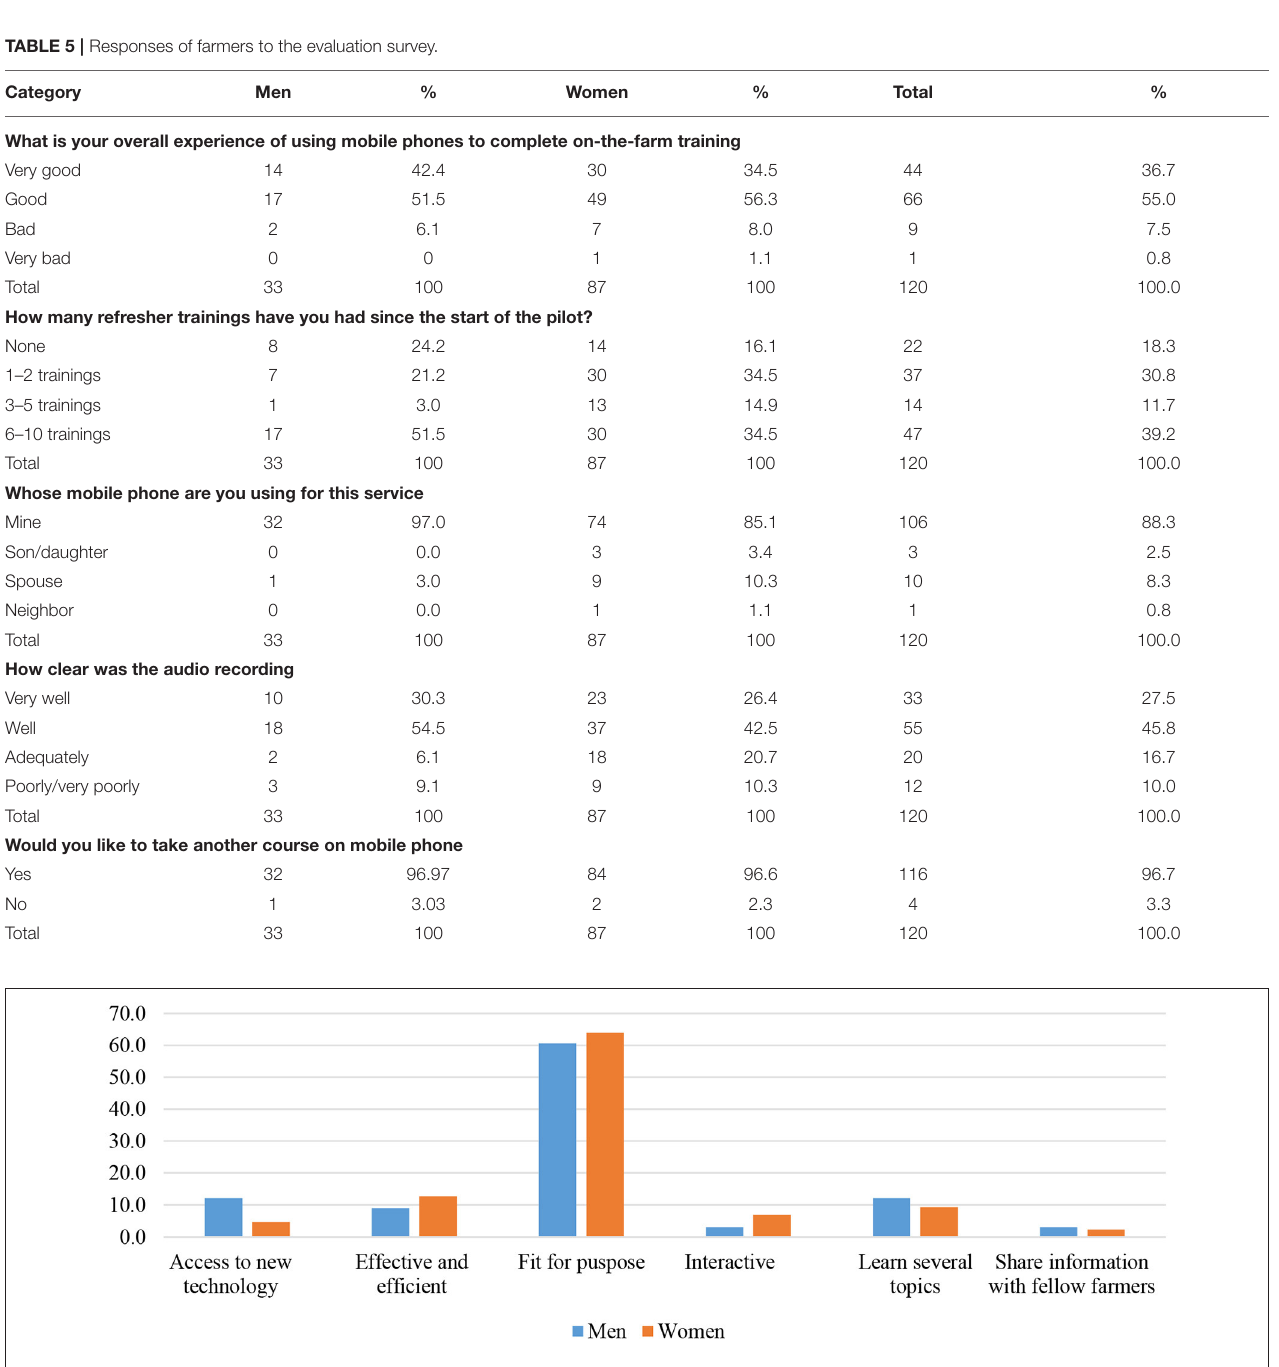
FIGURE 5 | Why would you want more mobile trainings? ( n =